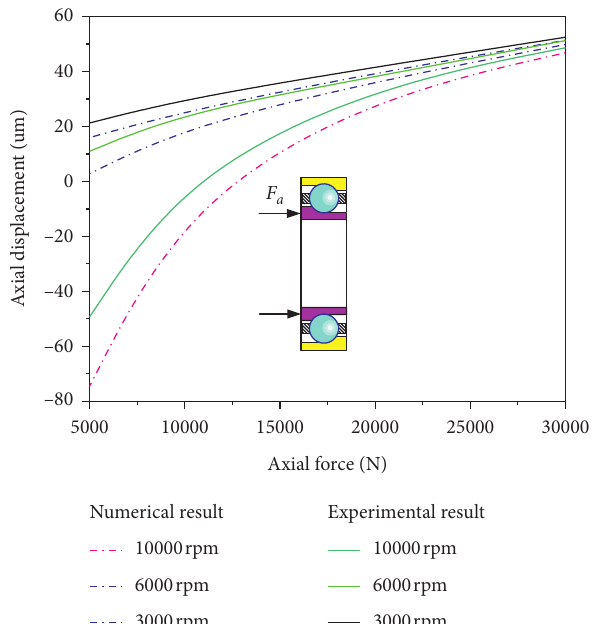
Figure 13: Axial deformation only under axial load.